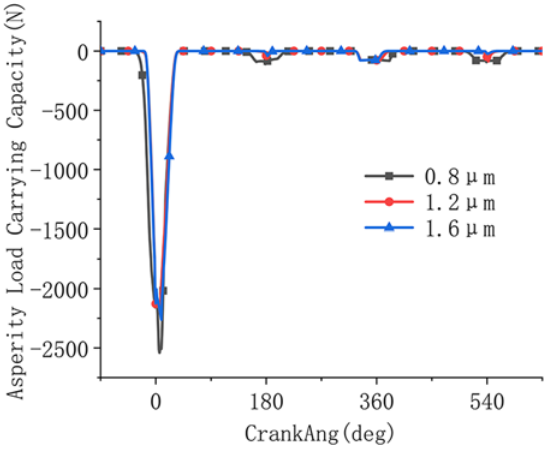
Fig. 14. Asperity load carrying